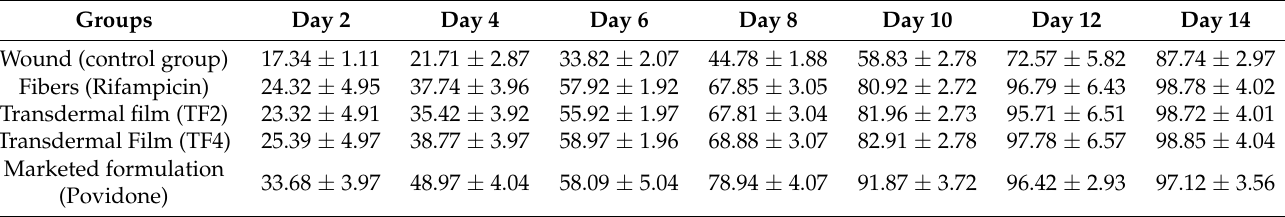
Figure 9. Scheme representing the actions and applications of fiber-in-film system. Table 6. Degree of Contraction data of control, fibers, transdermal films and marketed